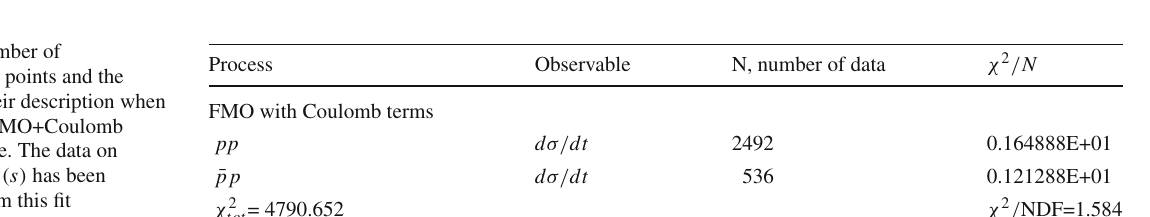
experimental points and the quality of their description when the fit with FMO+Coulomb terms is made. The data on σ ( s ) and ρ( s ) has been tot excluded from this fit